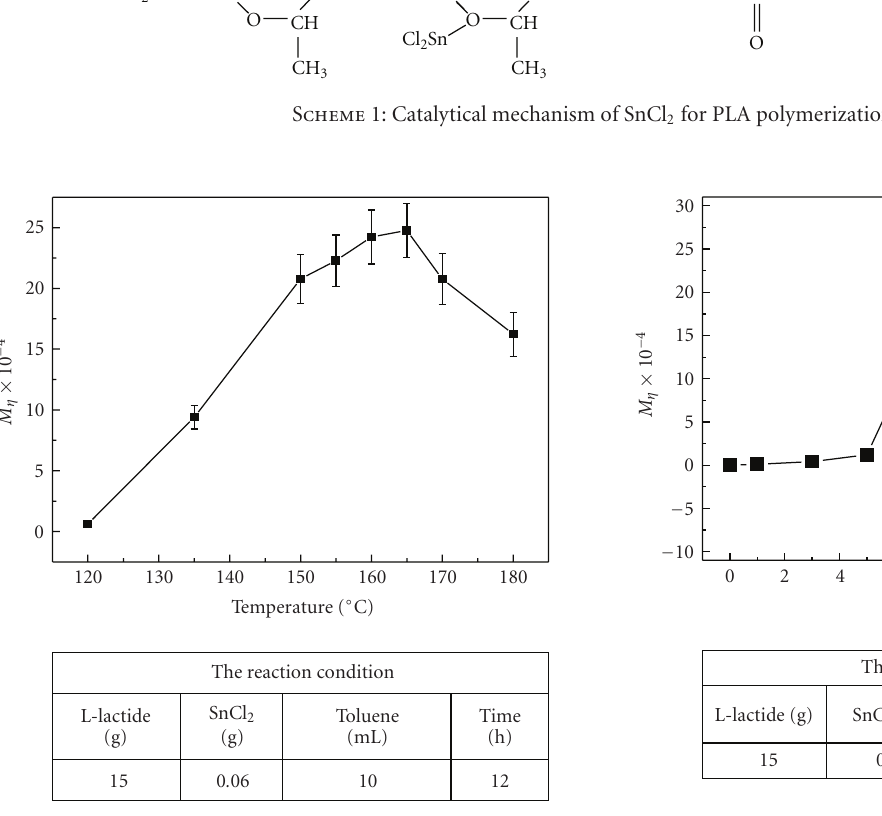
Figure 5: The relationship between the reaction time and M η of